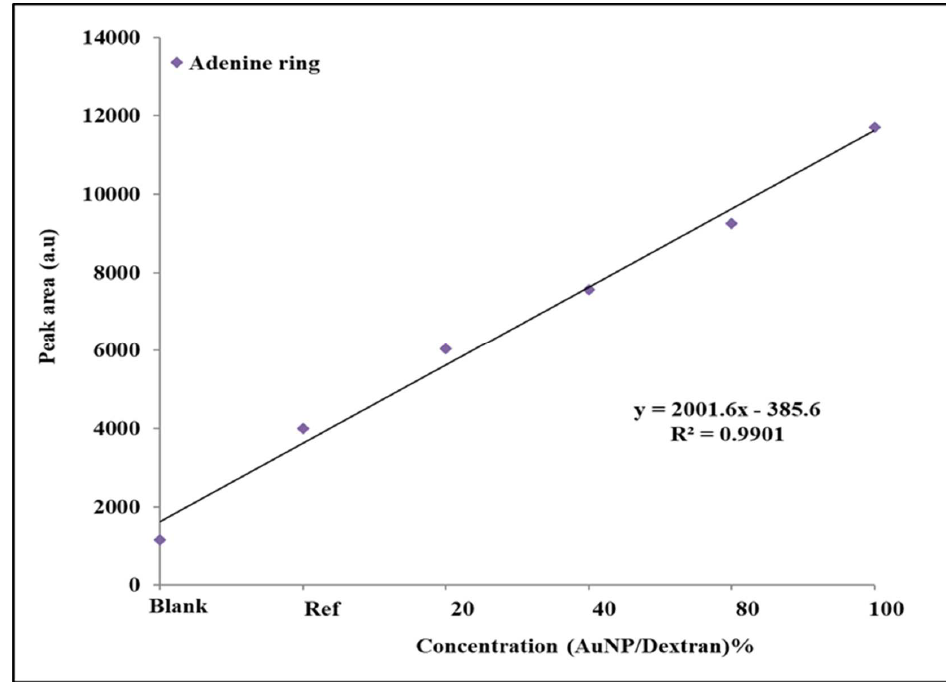
Figure 8. Linear plot of PA (ester) vs. Au/dextran concentration. The blank sample is 5% dextran, while the reference is 20% tenofovir in 5% Au/dextran NP solution. Experiments were performed in triplicate for each group. ( n = 3, SD 1.5–2.5). R 2 = 0.99.